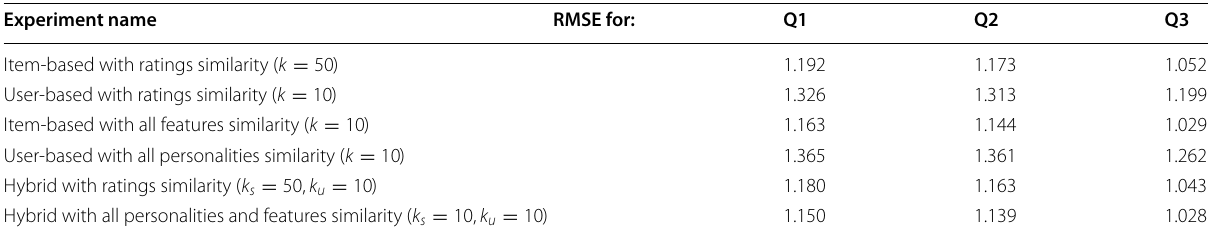
Table 2 RMSE (10-CV) calculated in baseline experiments, for each rating type. The k denotes the number of neighbors used for prediction, chosen